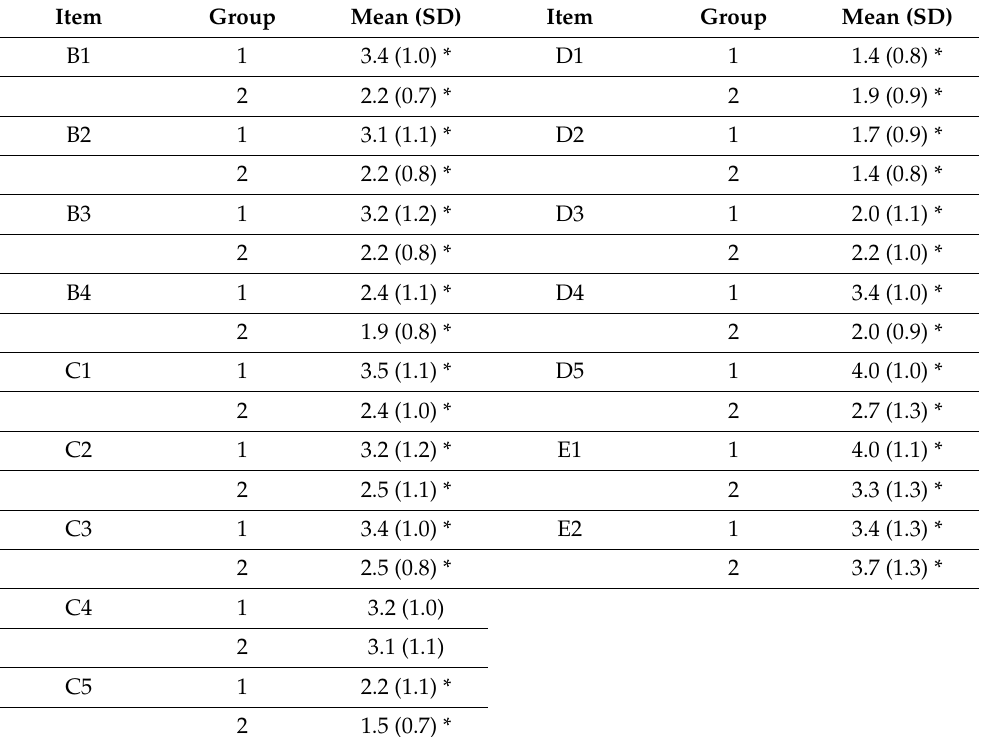
Table 3. Mean results (standard deviation) of questionnaire part B–E for both groups. Item Group Mean (SD) Item Group Mean